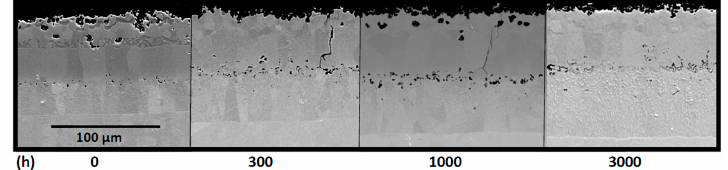
Figure 13. FESEM cross sections of aluminide coated HT347HFG exposed to atmospheric pressure steam at 700 °C as a function of time (hours).